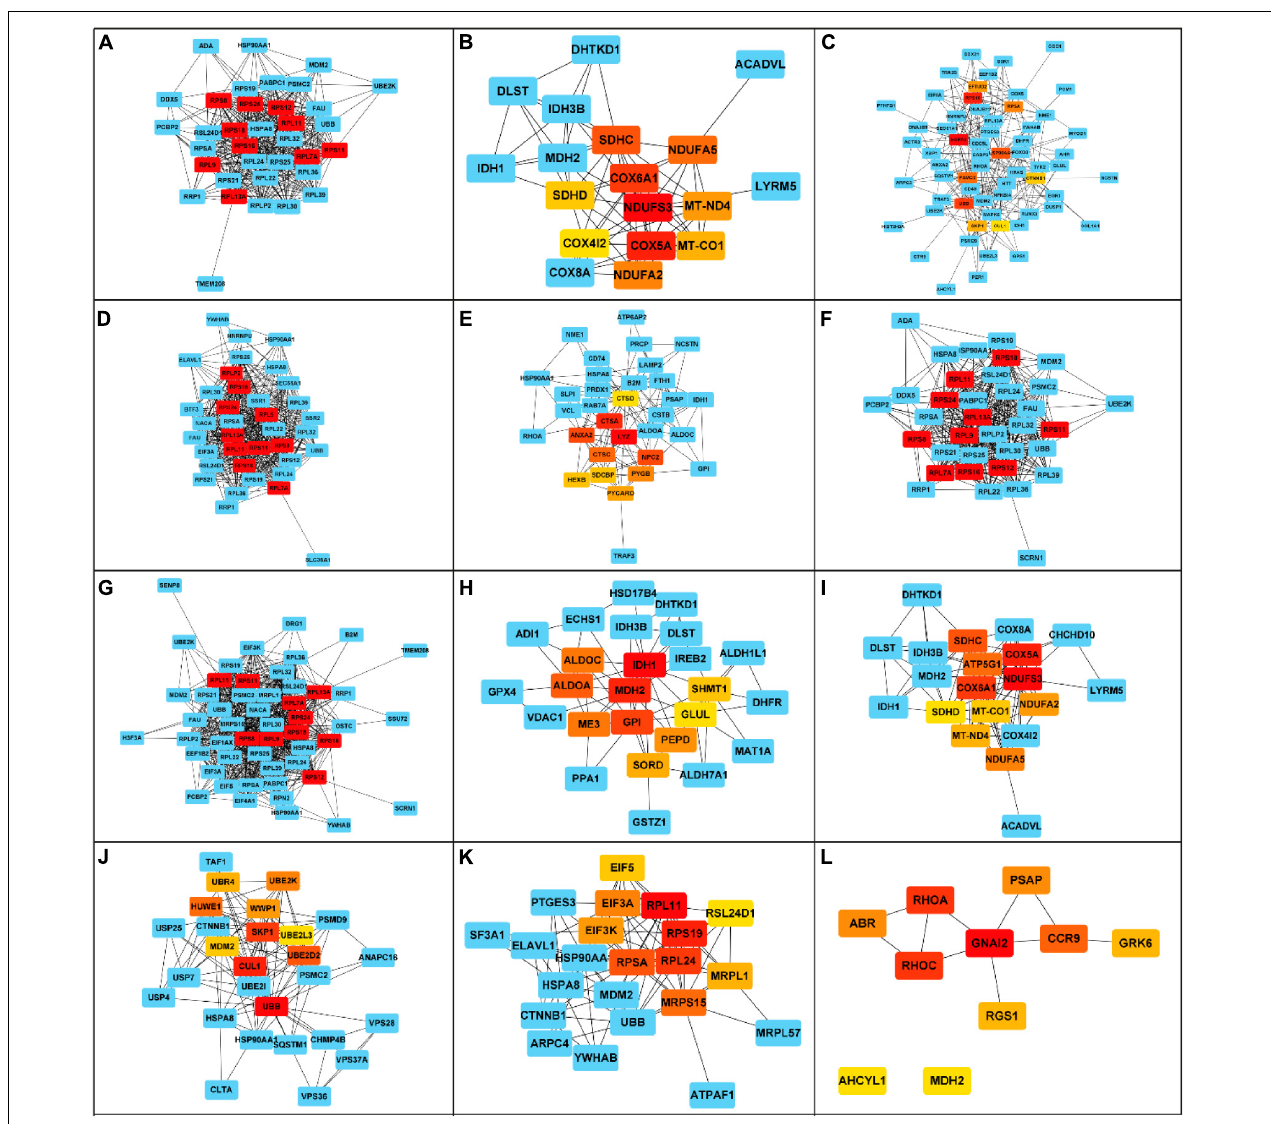
FIGURE 6 | Hub genes in each cluster term identified from the enriched biological functions in the anterior intestine of gilthead sea bream fed the SDPP diet. The principal cluster shows the 10-hub genes and the closest neighbor’s genes for each network. The color intensity from yellow to red (i.e., yellow, orange, red) represents the degree of the hub gene (i.e., the relevance degree) in each network, being red those most relevant hub genes. The blue nodes represent the closest neighbors. (A) Cellular catabolic process. (B) Energy derivation by oxidation of organic compounds. (C) Response to organic substance. (D) Protein transport. (E) Leukocyte mediated immunity. (F) Organic substance catabolic process. (G) Protein metabolic process. (H) Carboxylic acid metabolic process. (I) Generation of precursor metabolites and energy. (J) Protein catabolic process. (K) Protein containing complex subunit organization. (L) G protein-coupled receptor signaling